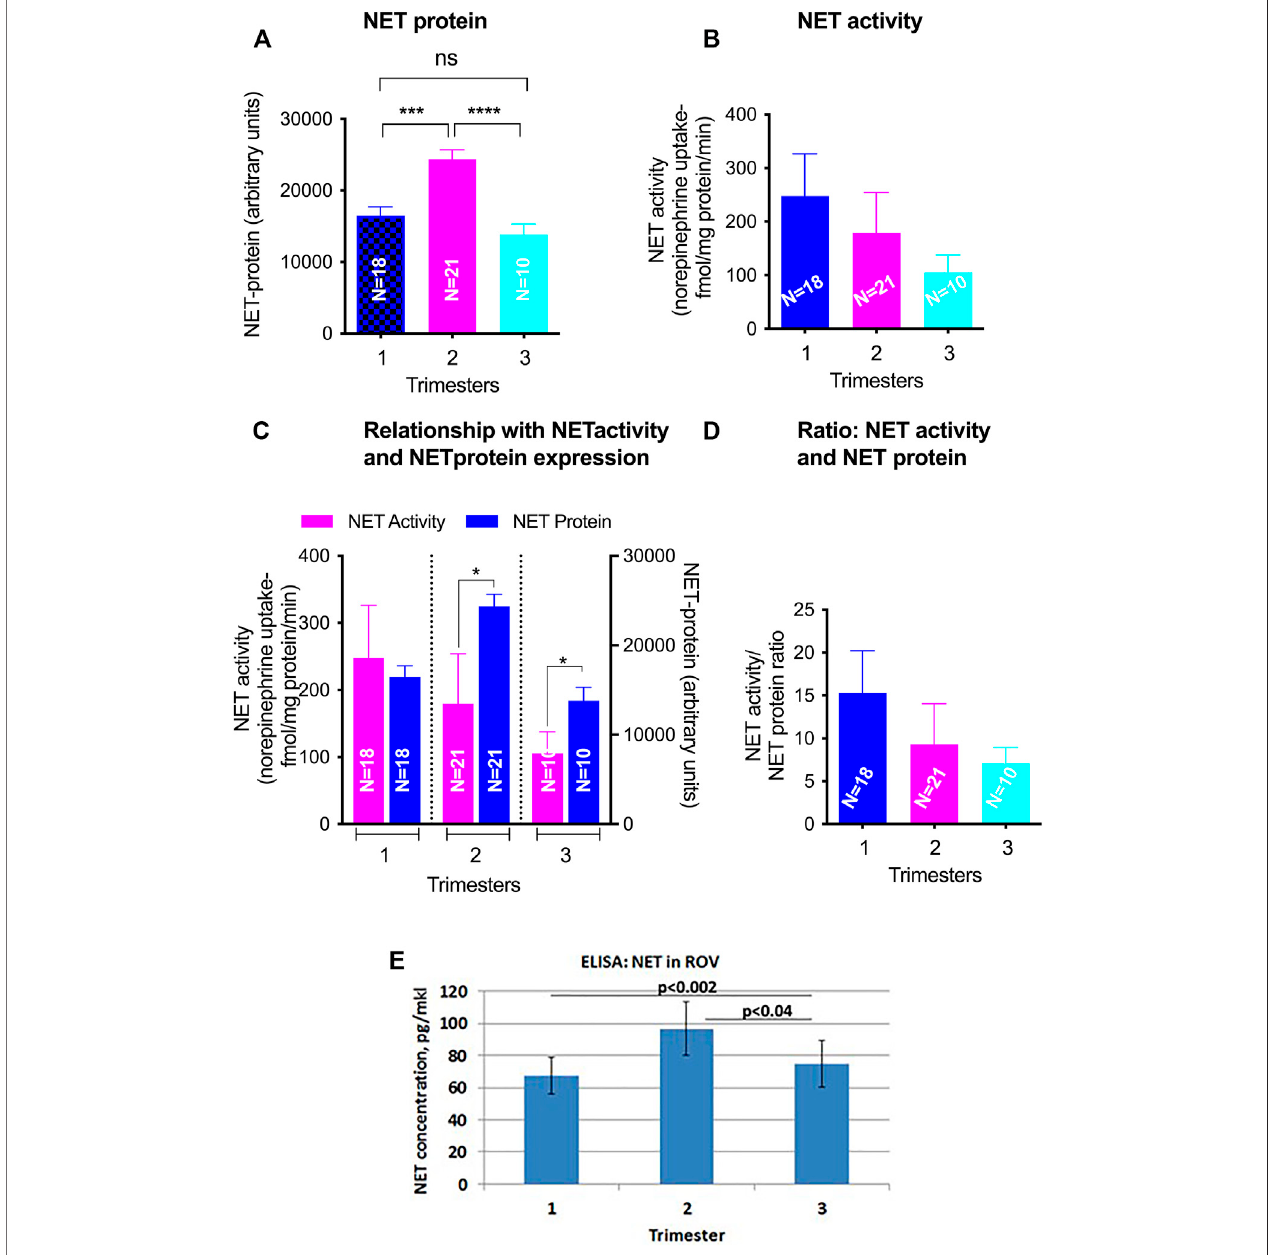
FIGURE 6 | GA differences in total NET levels and activity in ROV placental vesicles. Total NET quanti fi ed by Western blot in matched samples used for activity assays (A) . NET-mediated norepinephrine uptake and the level of NET protein expression was determined using radiolabelled NE and NET speci fi c antibody (B) . The relationship of SERT mediated 5-HT transport and SERT protein levels from the same membrane vesicles across gestations was analyzed (C,D) . Levels of SERT transporter in ROV were also assayed by ELISA [ (E) ; pg/mkl of vesicles]. Symbols represent the following levels of statistical signi fi cance: * p < 0.05, *** p < 0.001, **** p <